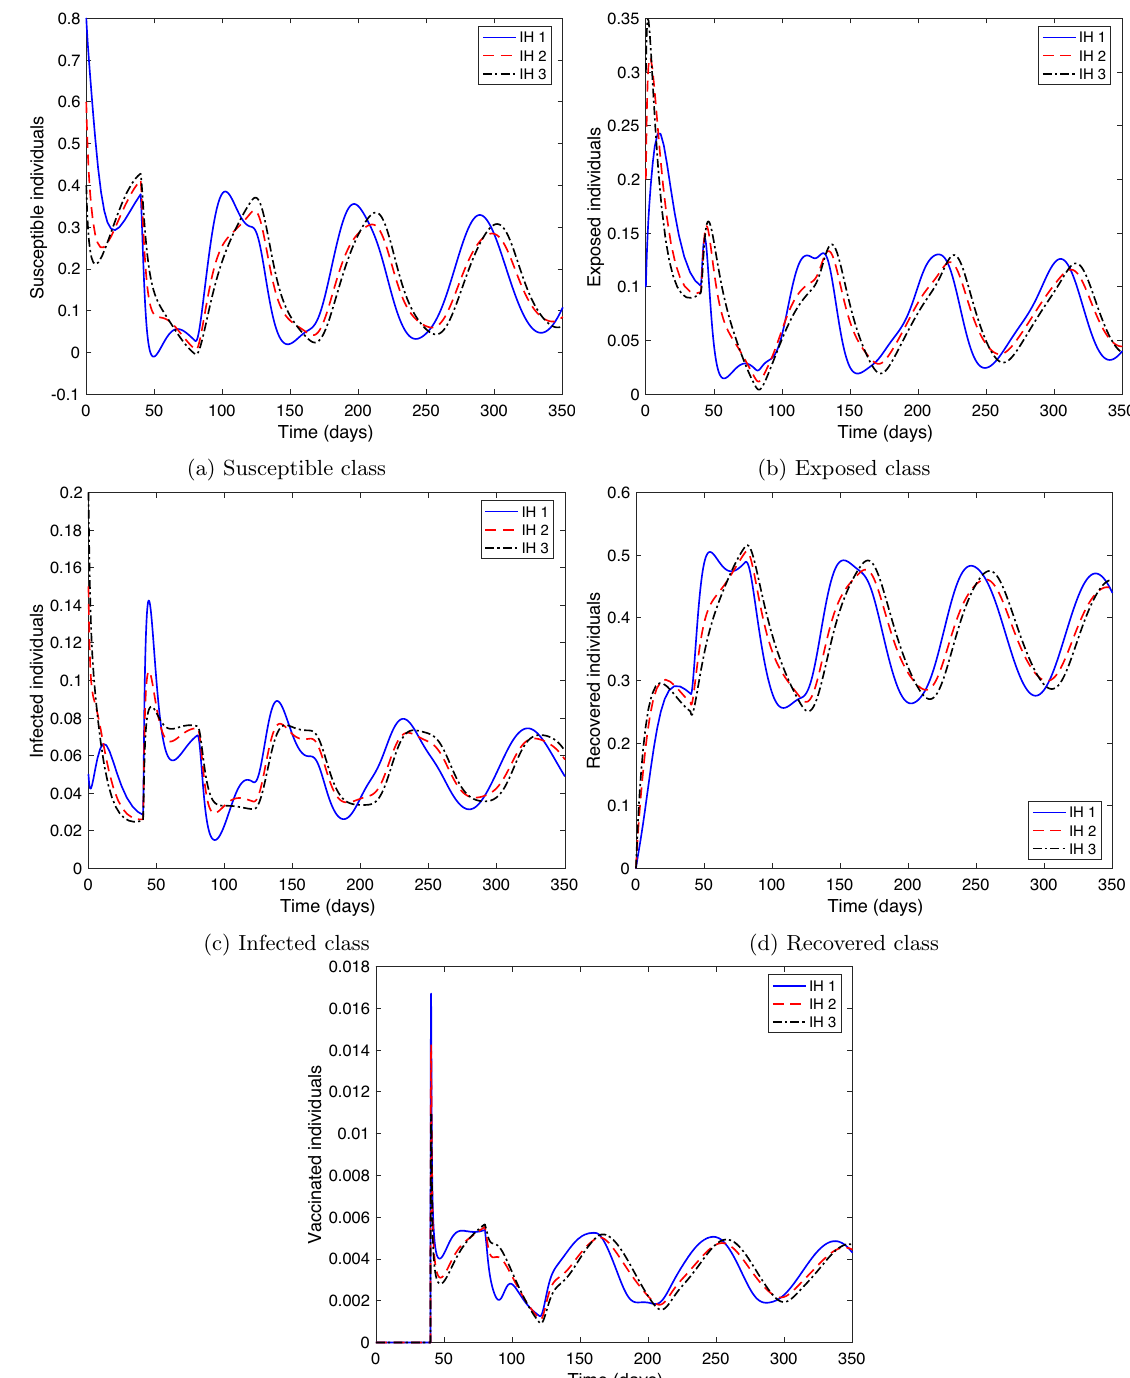
Figure 5. Numerical solution of system (25) versus time with different initial histories where R c > 1 , and the stability conditions (17) are satisfied, but conditions in (23) are not